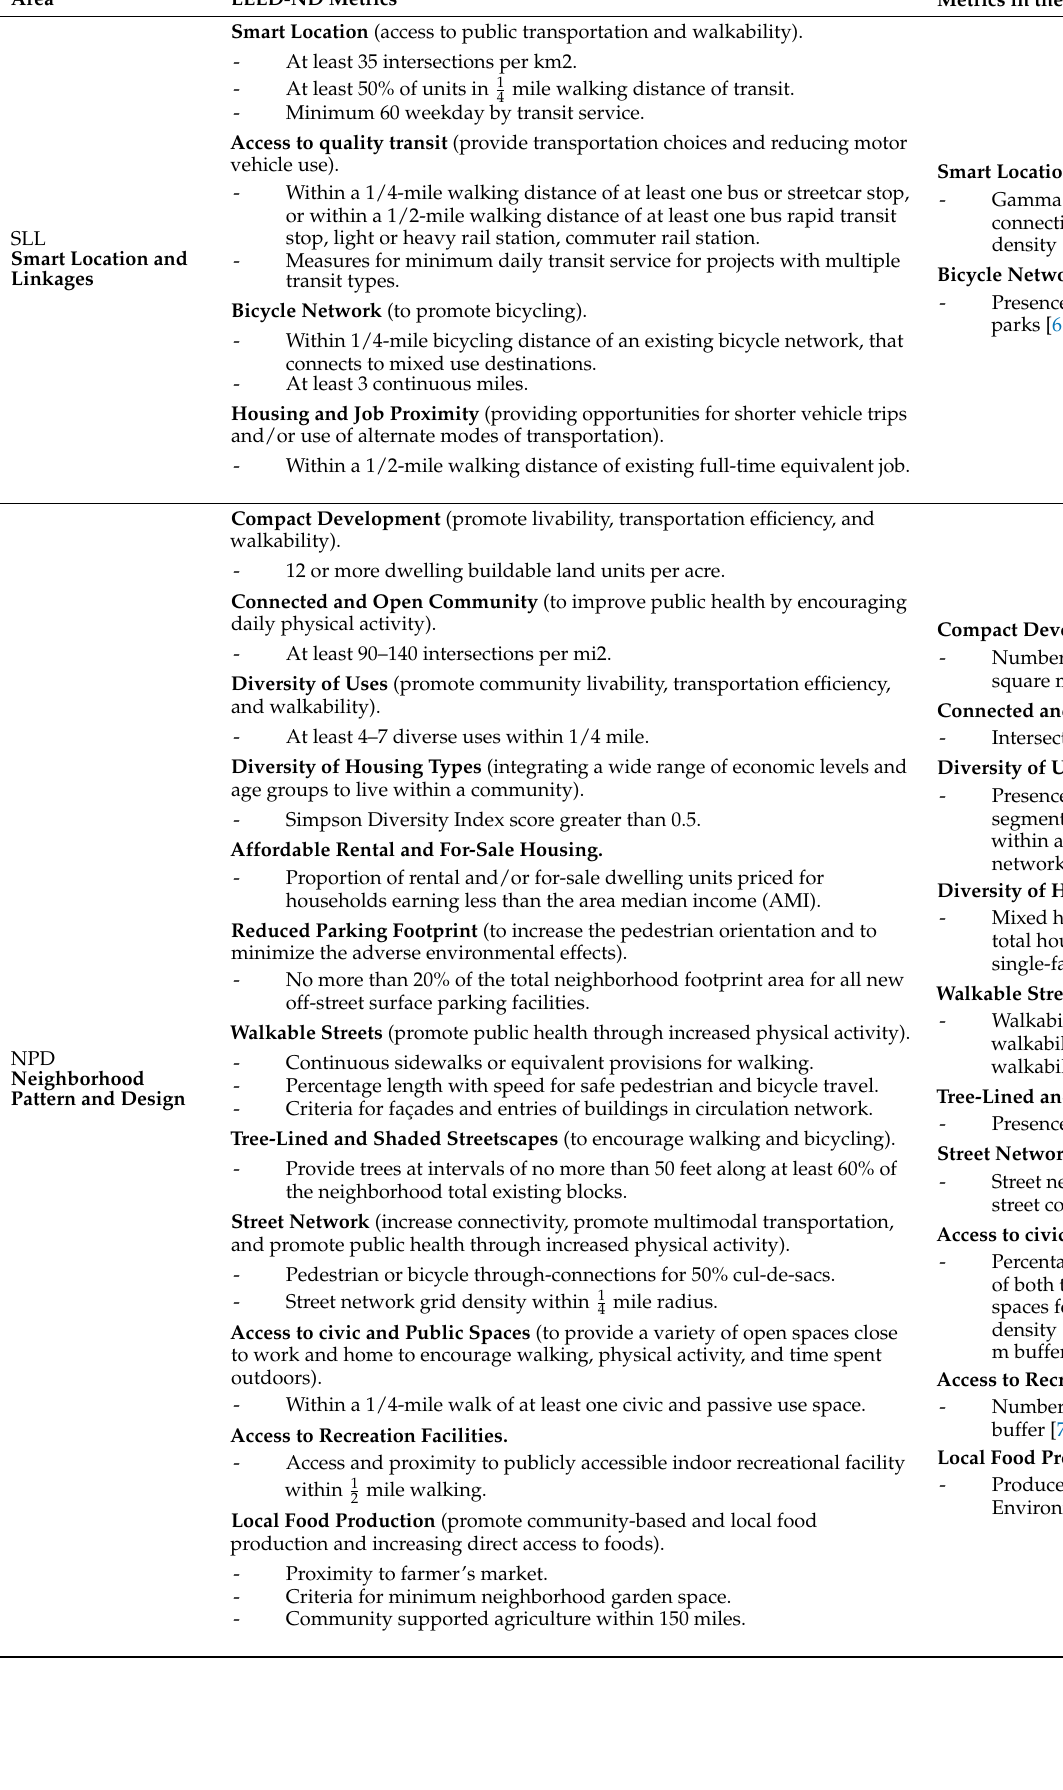
Table 1. LEED-ND Metrics for Healthy Neighborhoods [45,50] and the corresponding measures in the scoped articles. Area LEED-ND Metrics Metrics in the Scoped Articles